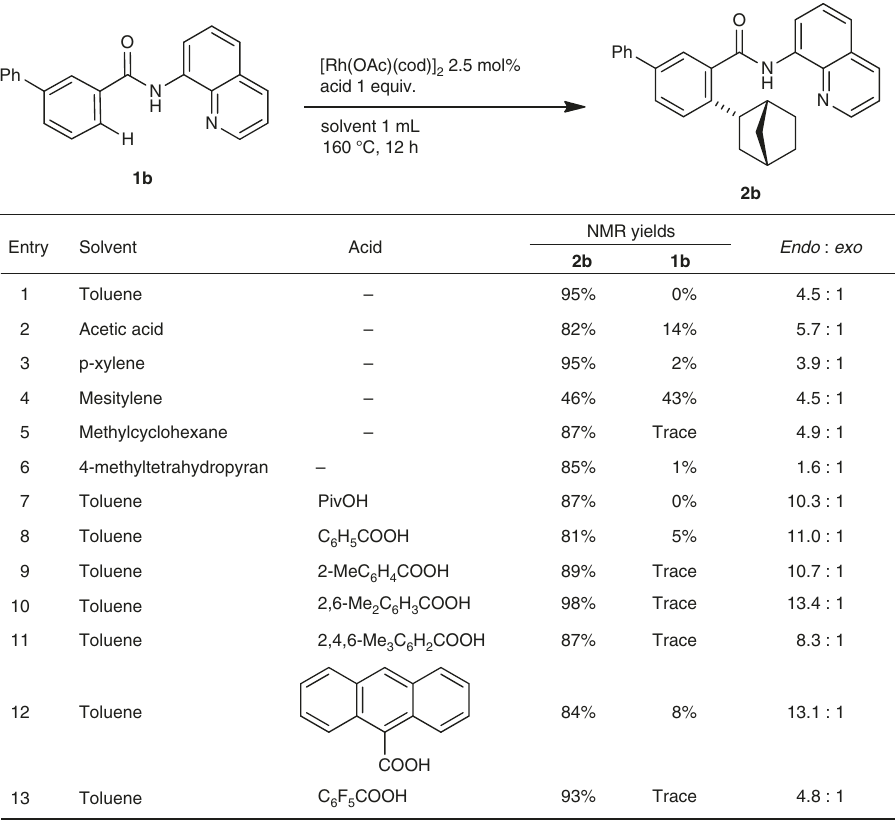
Fig. 3 Endo -selective hydroarylation of C – H bonds with norbornene. The use of bulky carboxylic acids as additives dramatically improved the endo -selectivity of the